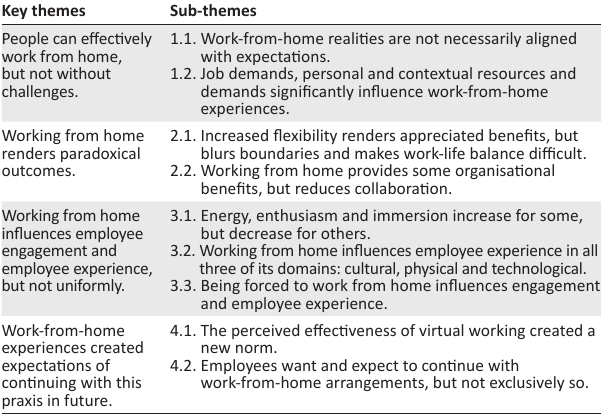
TABLE 1 : Key themes and sub-themes of the thematic